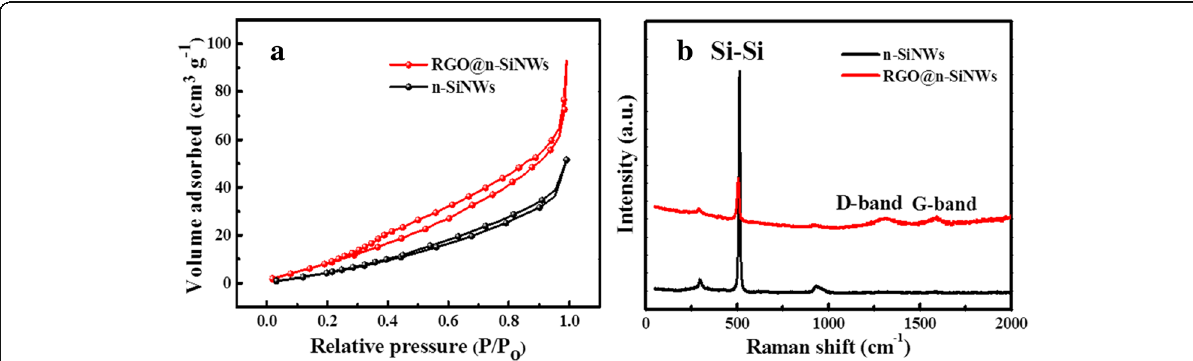
Fig. 6 a Typical nitrogen adsorption isotherms of n-SiNWs and RGO@n-SiNWs. b Raman shift of n-SiNWs and RGO@n-SiNWs, and the zoomed-in Si-Si peaks as shown in